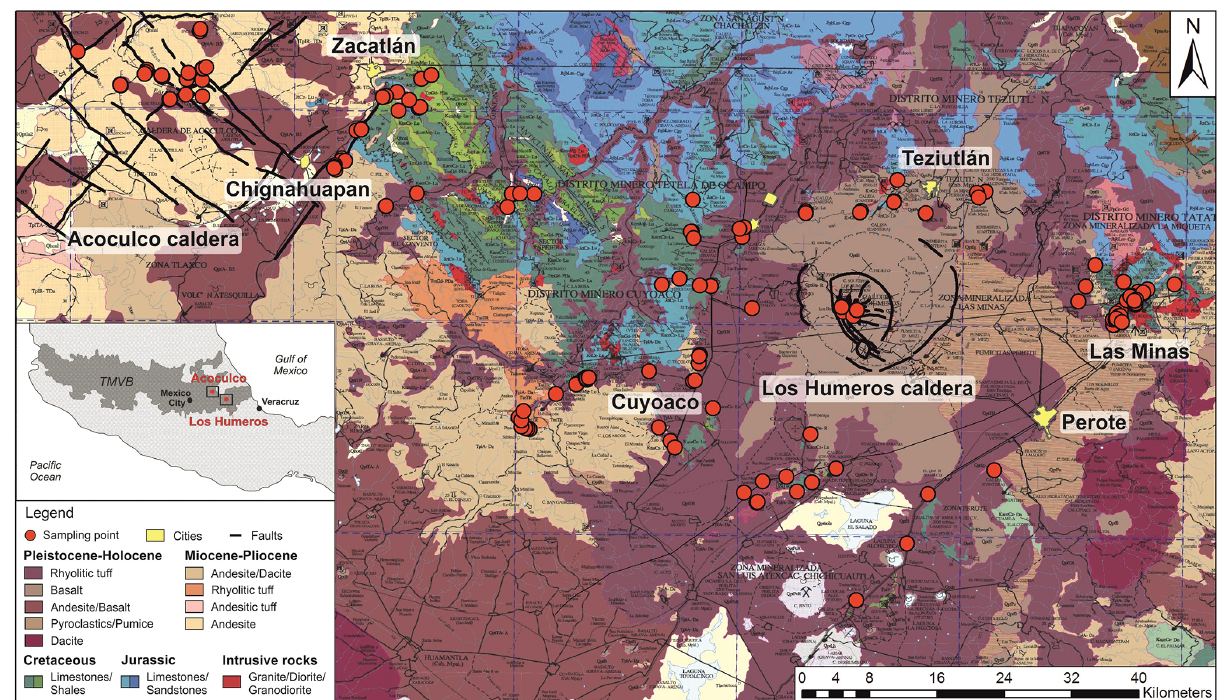
Figure 2. Geological map of the Acoculco and Los Humeros region including the sampling points of the outcrop samples (SGM, 2002a, b). The faults were recently mapped and characterized by Liotta et al. (2019) and Norini et al.